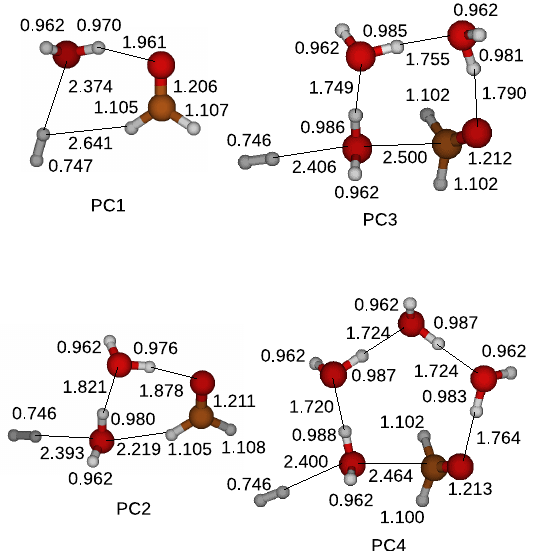
Figure 5. Optimized structures of the reactant compounds that consist of a CH We use the Gaussian 4 method and optimize the reactant compounds. We introduce up to four H molecules in the simulations as catalyst. RC n stands for Reactant Compounds when the oxidation of a CH OH is catalyzed by n H O molecules in a ring structure. 3 2